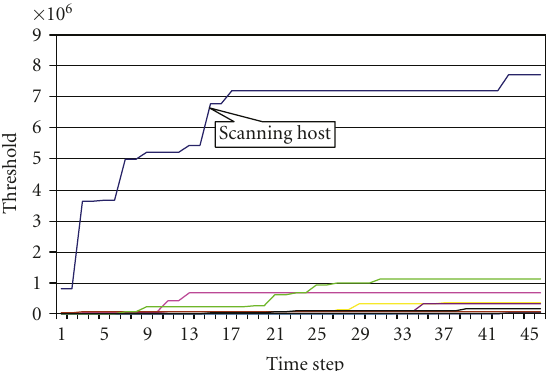
Figure 7: USC tra ffi c threshold analysis (ACK